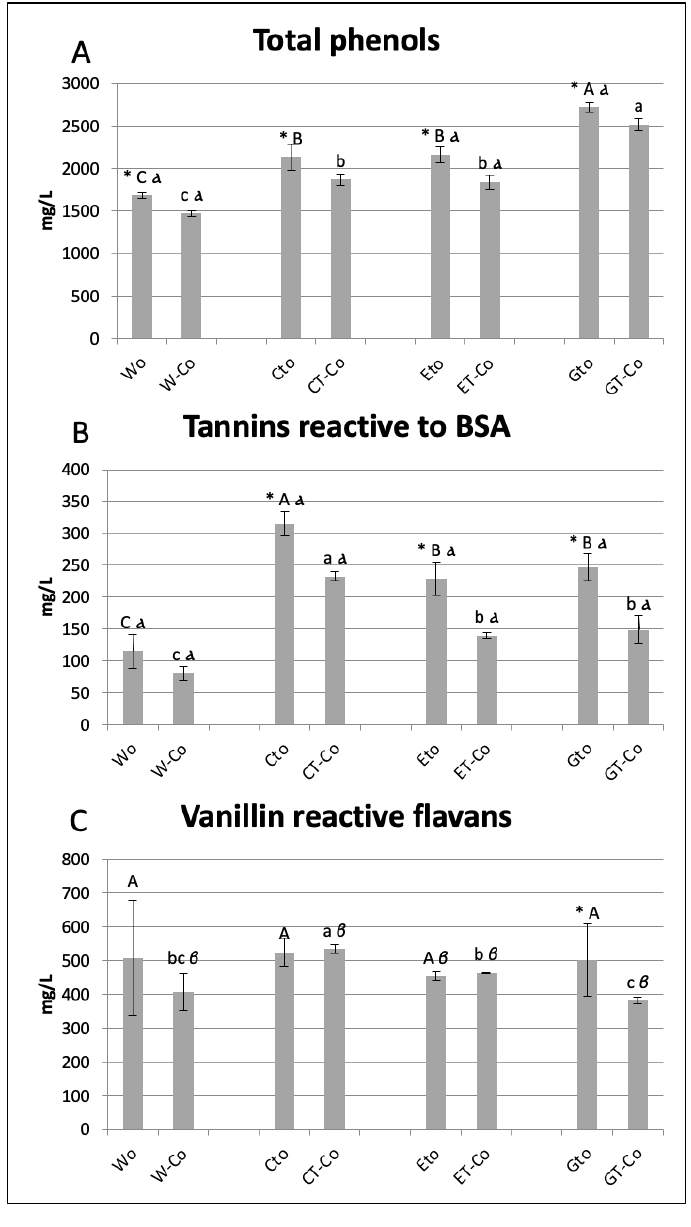
Figure 2. Oxidation effect on total phenols ( A ), tannins reactive to BSA ( B ), and vanillin reactive flavans ( C ) of treated wines. Different letters indicate a statistically significant difference among Table 7. Oxidation effect on total anthocyanins, colour intensity, and tonality of treated treated wines according to Tukey’s (HSD) analysis ( p < 0.05). The effect of tannins addition is expressed with a capital letter on wines Wo, CTo, ETo, and GTo (A, B, C), and the effect of chitosan addition is expressed with a lowercase letter on wines W-Co, CT-Co, ET-Co, and GT-Co (a, b, c). The asterisk (*) indicates a statistical difference between each kind of wine before and after the treatment with chitosan. The Greek symbol (